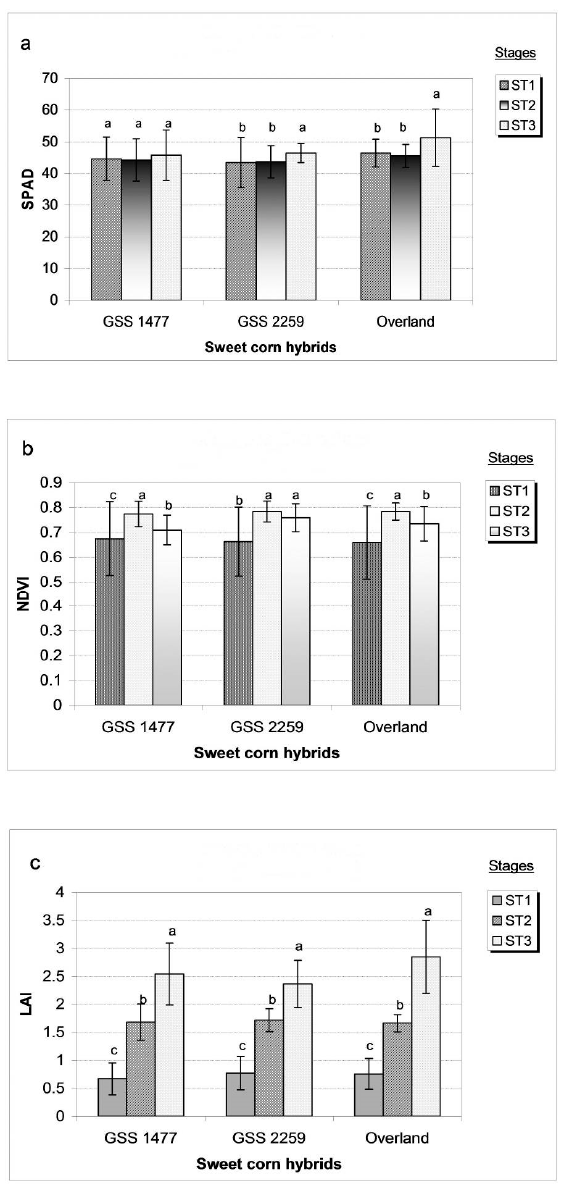
Figure 2. Changes in SPAD values ( a ) and normalized vegetation differential index (NDVI) ( b ) and leaf area index (LAI) ( c ) under growth stages (ST1 = eight leaf-aged, ST2 = tasseling, ST3 = silking). The data presented the average of years ± SD. Mean values followed by the different letters are significantly different at the p < 0.05 level.